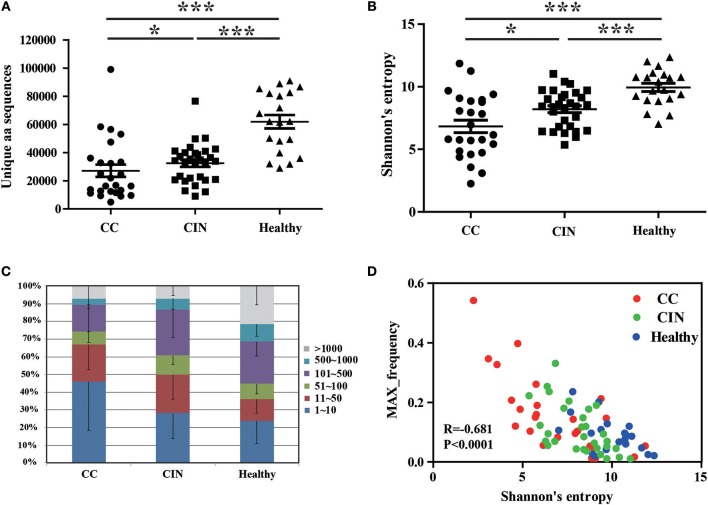
Clonal distributions of peripheral blood T cell repertoires in the CC, CIN patients and healthy women. (A) The number of unique TCR CDR3 aa sequences and (B) The Shannon's entropy of TCR repertoire in peripheral blood of the CC, CIN patients and Healthy women. Bars depict the mean (±SEM) of the groups. *P < 0.05, ***P < 0.001, Kruskal wallis test. (C) Percentage of the top 1,000 frequent TCR CDR3 aa sequences in each group. (D) The correlation between the Shannon's entropy and the frequency of the largest dominant clone, Pearson correlation test.